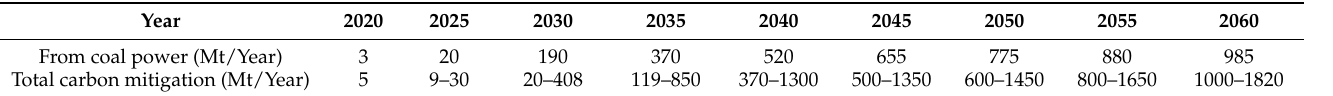
Table 14. Coal power and national CCUS-related emission reduction demand for baseline scenario,